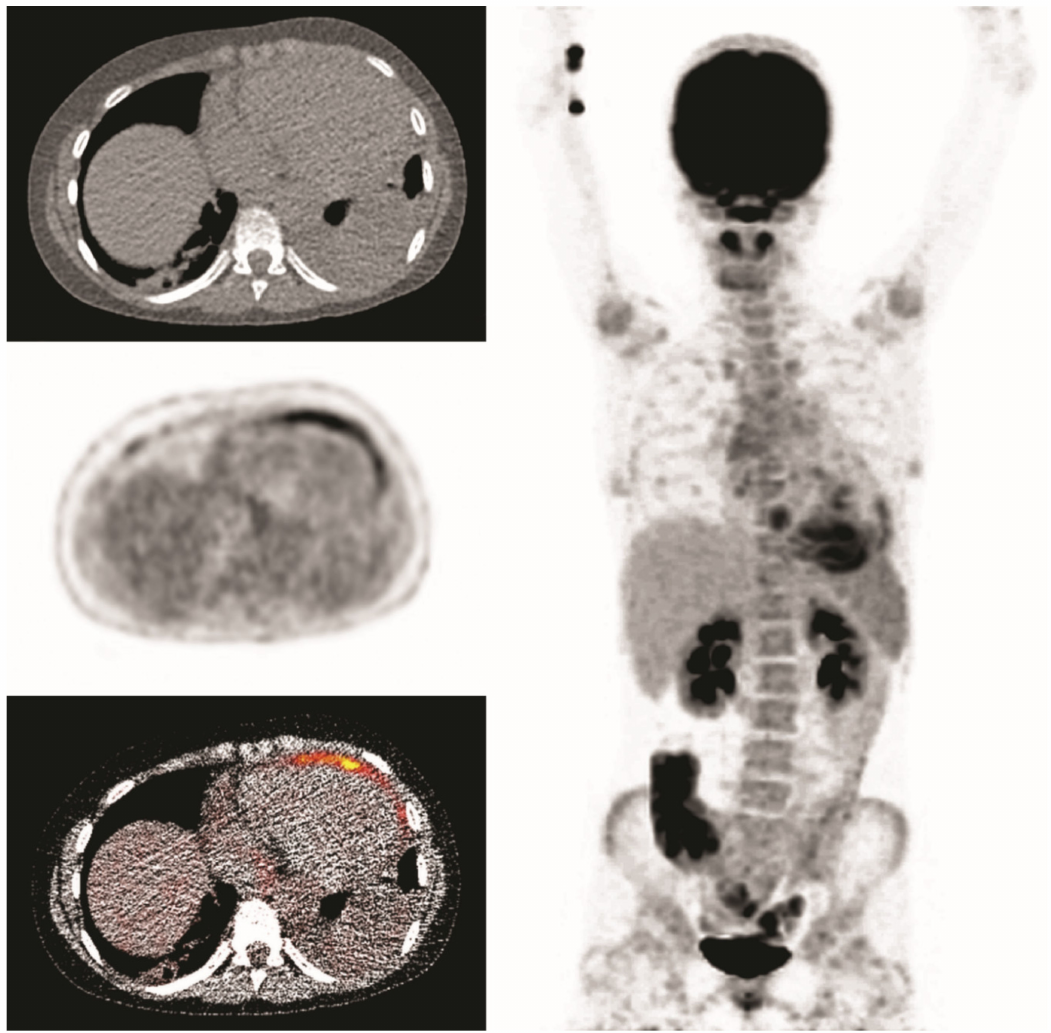
Figure 5. Clinical example 1. Pericardial FDG-uptake is present, most pronounced around the apex and anterior